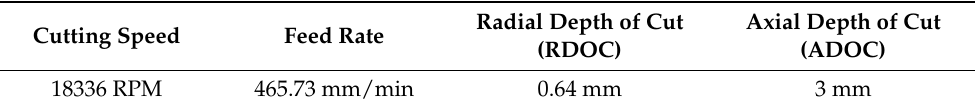
Table 2. Mechanical properties of AISI 5140 steel.